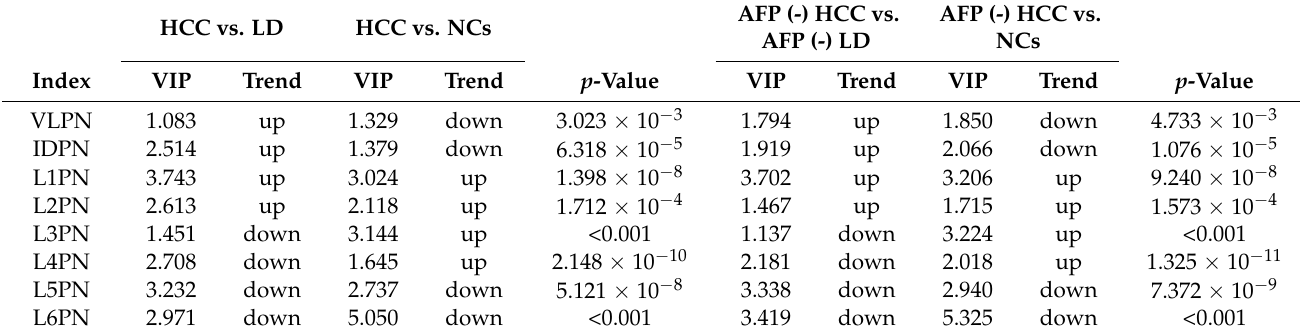
Table 4. Changes in relative levels of lipoprotein subfractions in serum samples from HCC patients, liver disease patients and normal